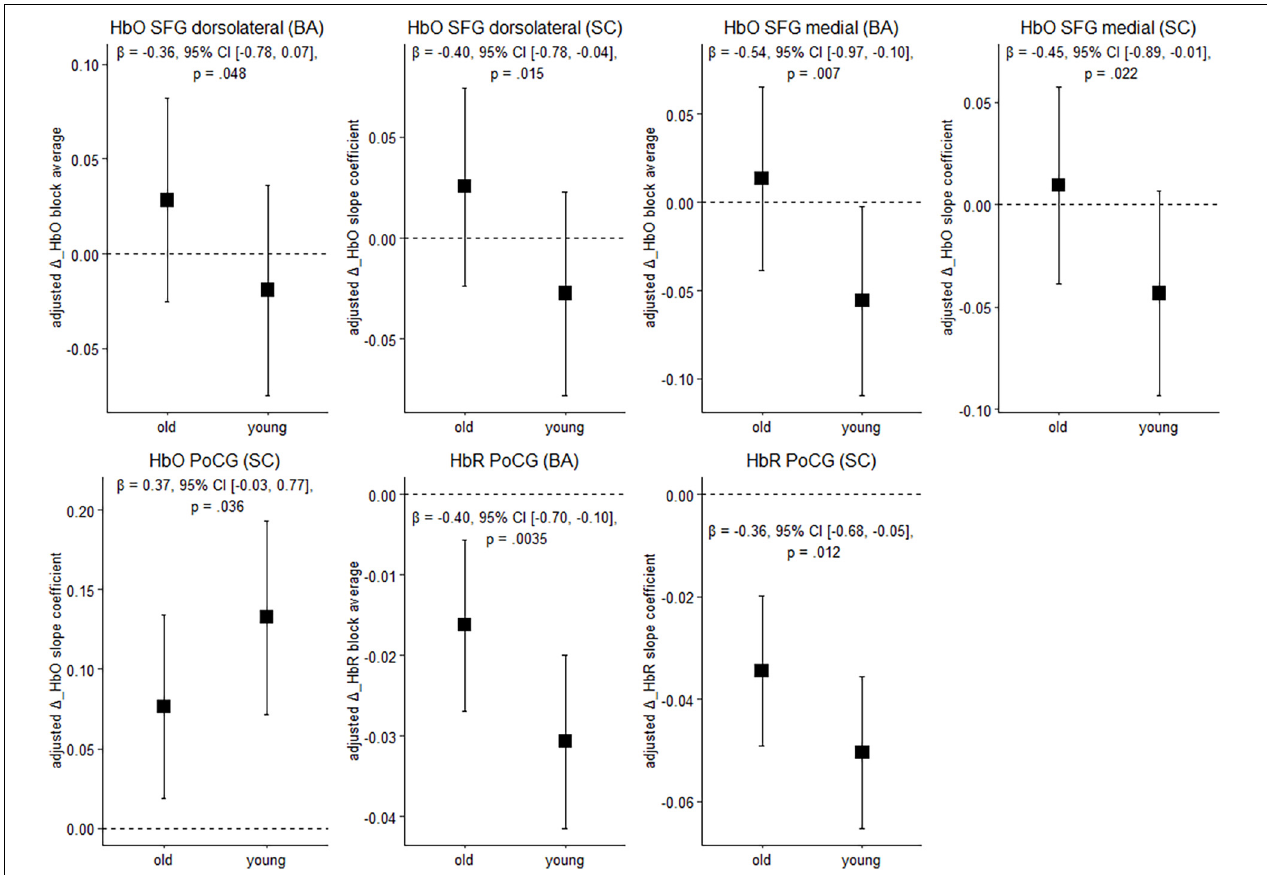
FIGURE 4 | Balancing-induced neural activity in older and younger participants. Data are presented as predicted group means (corrected for the influence of sex and Baecke’s sport score) and the corresponding 95% CI (error bars). Note that the beta-coefficients reflecting the between-group differences in units of standard deviation are conceptually similar to Cohen’s d . Rules of thumb for interpreting this effect size are 0.2 < | β | < 0.5 “small,” 0.5 < | β | < 0.8 “medium,” and | β | > 0.8 “large” effects, respectively (cf. Cohen, 1988). All p -values that are given in the figure are not adjusted for multiple comparisons (see Supplementary Table 2 , for FDR-corrected p -values). HbO, oxygenated hemoglobin; HbR, deoxygenated hemoglobin; BA, block average; SC, slope